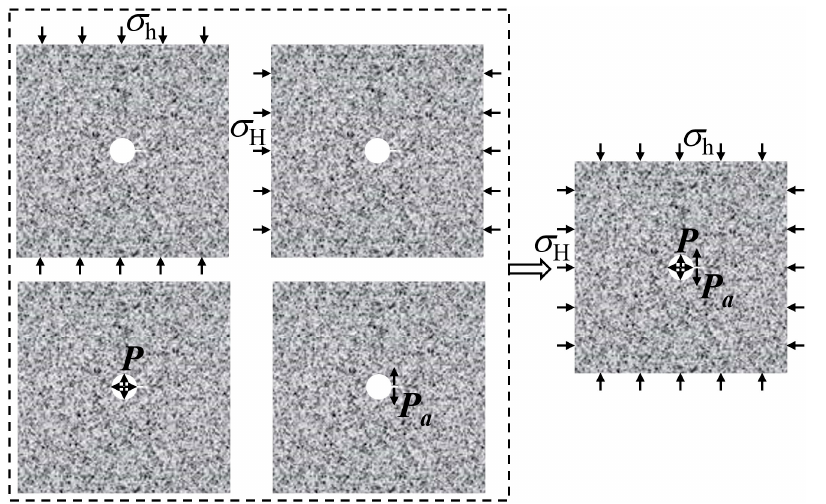
Figure 14. Superposition of four kinds of fracture type.